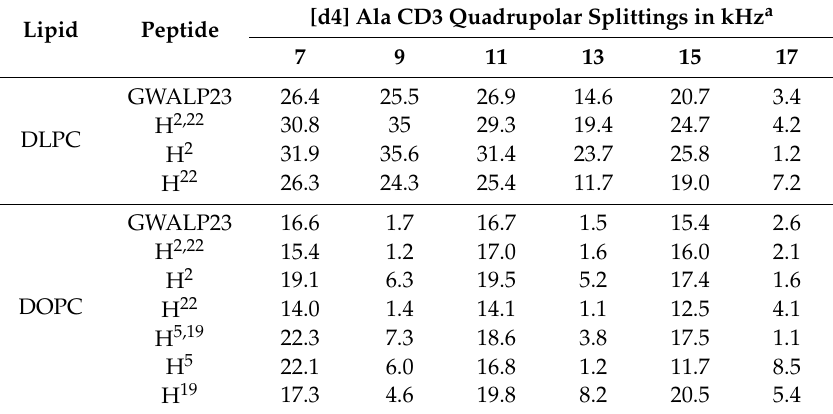
Table 2. 2 H-NMR quadrupolar splitting magnitudes of labeled core alanines of GWALP23 family peptides with single and double histidine